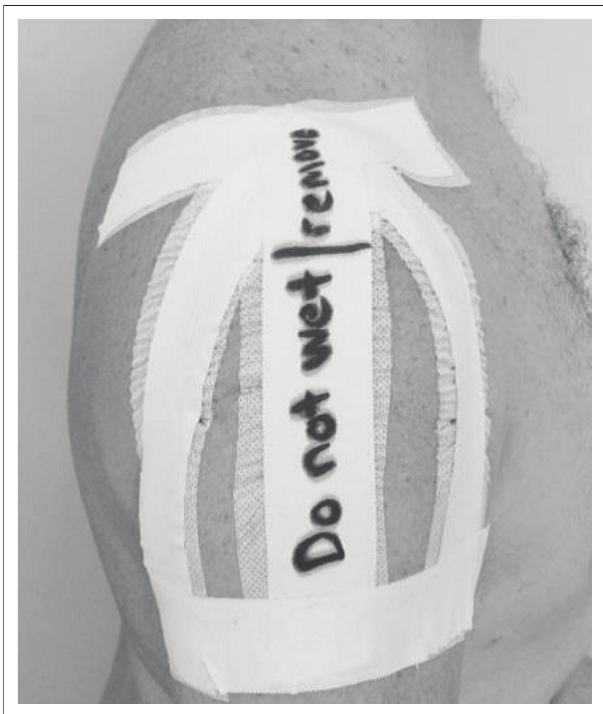
Source : Photo taken by N. Comley-White FIGURE 1: Longitudinal strapping.